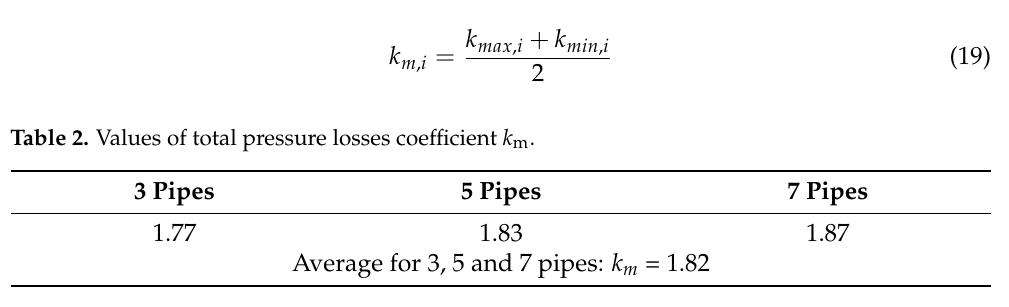
Table 2. Values of total pressure losses coefficient k m .